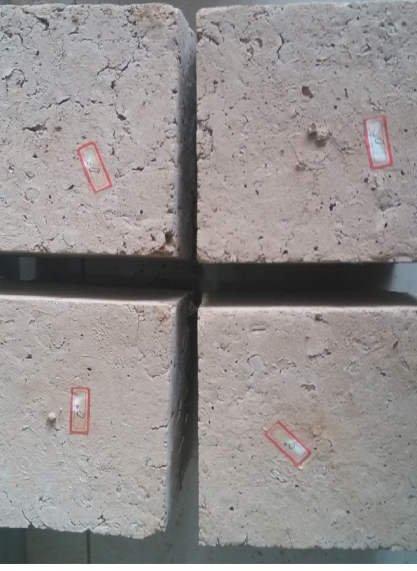
Figure 12: Samples of SRMCM before the indoor direct shear test.